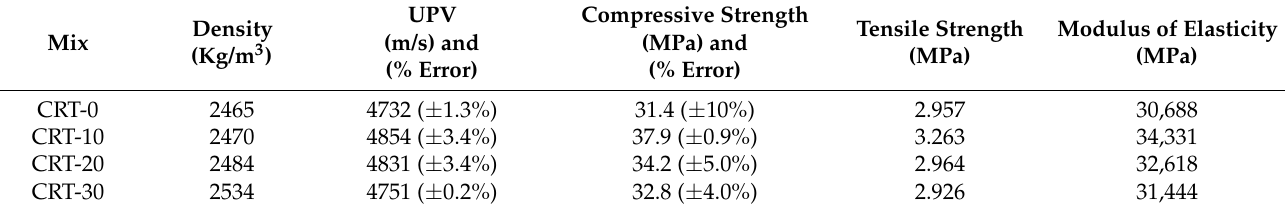
Table 3. Mechanical properties of concrete mixes at 28 days of